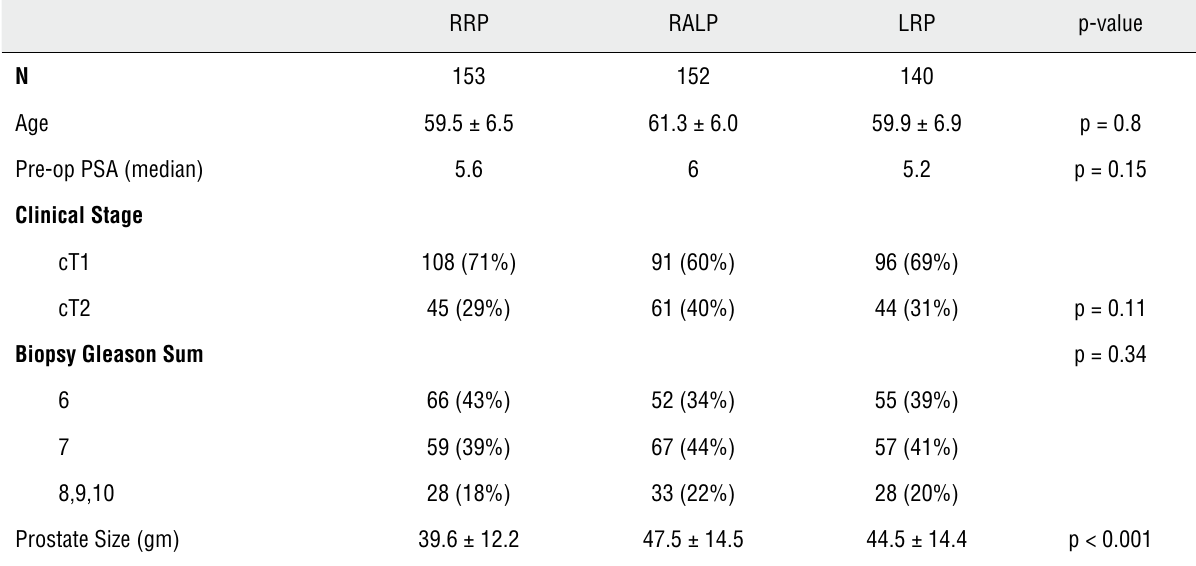
Table 1 - Patient and clinical tumor